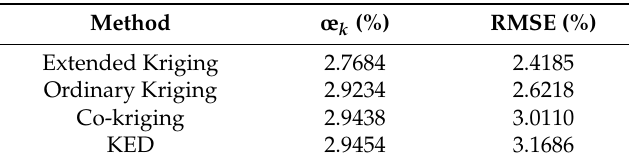
Table 1. Comparison of the interpolation results for the Extended Kriging method, OK method, Co-kriging method, and KED method on 10 July 2012.